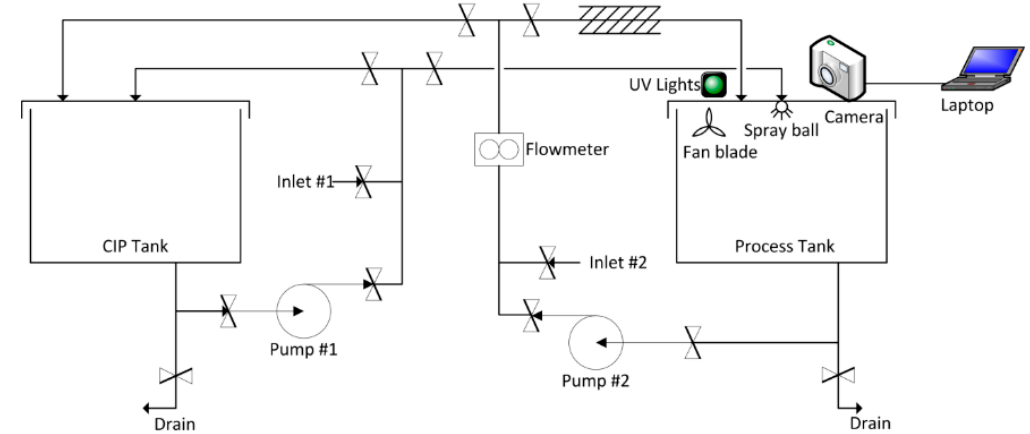
Figure 2. Experimental rig scheme.